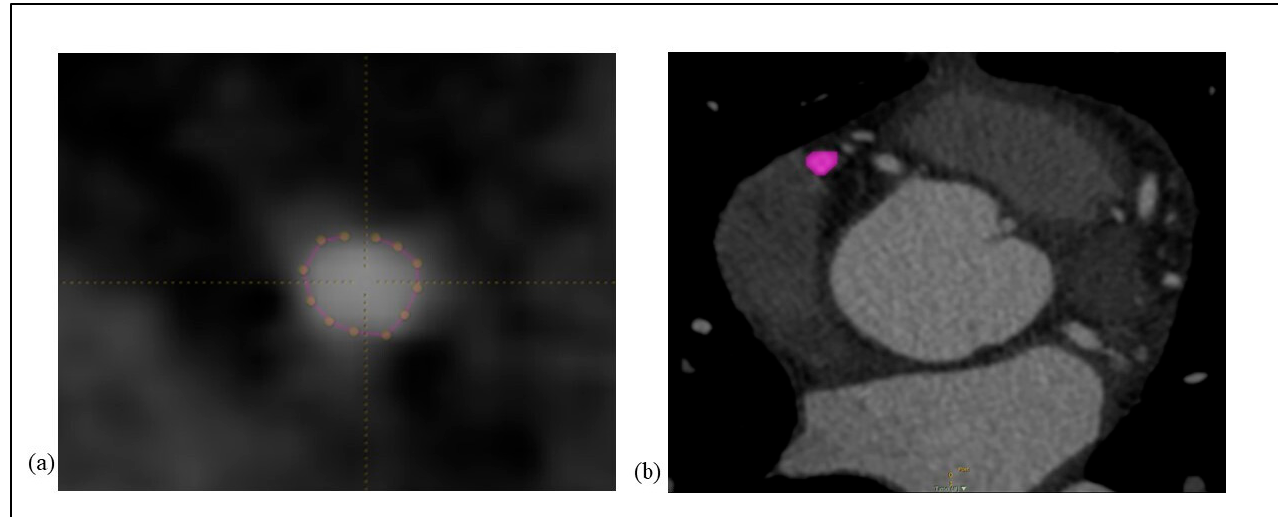
Figure 4. LIFEx software was used to perform manual and semiautomatic segmentation on RCA, LAD, and LCX. ( a ) Manual segmentation using pencil 2D technique with soft-tissue-windowing setting on RCA ( b ) The area of segmentation covered after manual segmentation with soft-tissue- windowing setting was performed on RCA.